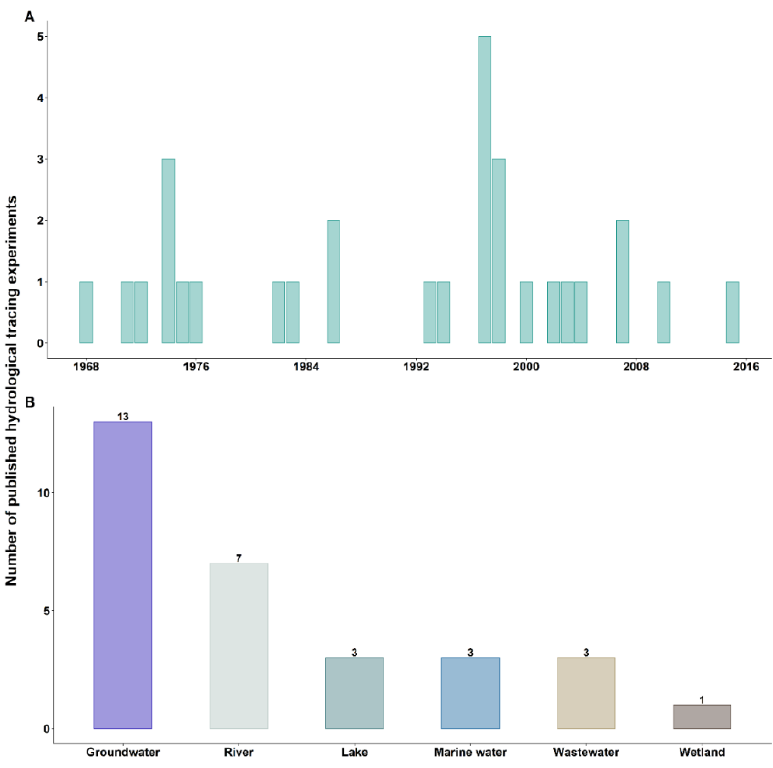
Figure 1. Total number of scientific papers reporting the use of bacteriophages during hydrological tracing experiments according to the year of experiments ( A ) and categorised by the water type investigated ( B ).